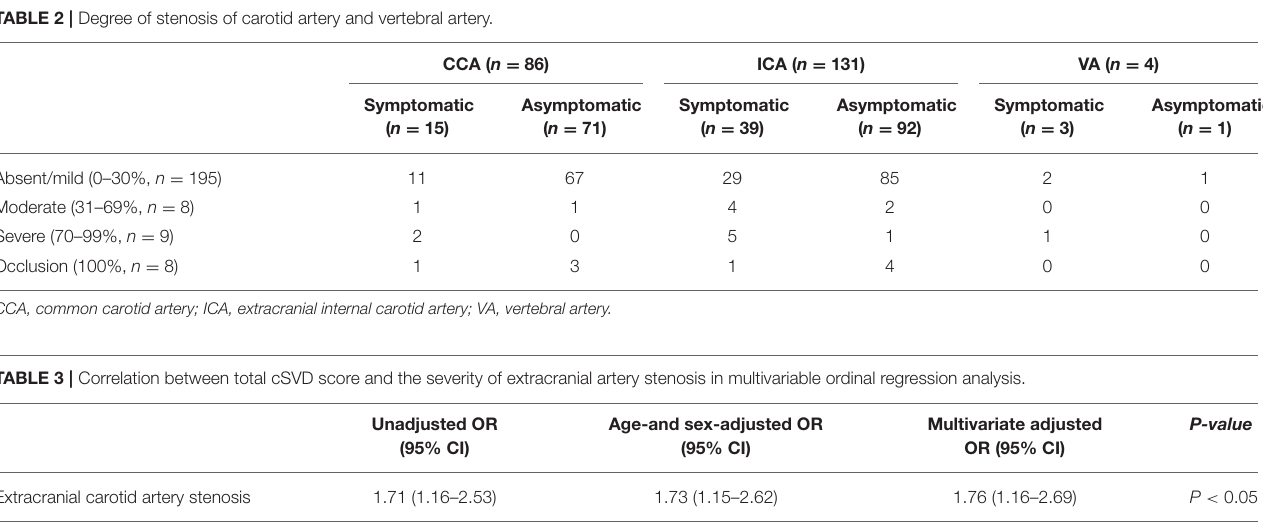
Unadjusted OR Age-and sex-adjusted OR (95% CI) (95%